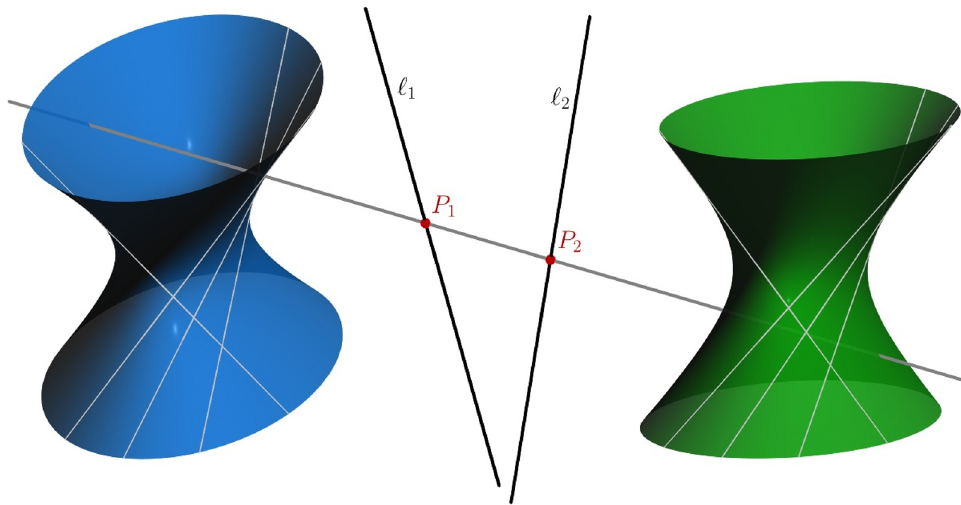
Figure 4 . Quadrics and lines de(cid:12)ning the K3 surface in the three-loop traintrack diagram. curve matches the j -invariant of the curve constructed directly in momentum twistor space above. This is an encouraging result as it means that the geometry is not merely an artifact of the chosen parametrization but an intrinsic property of the leading singularity of the double box